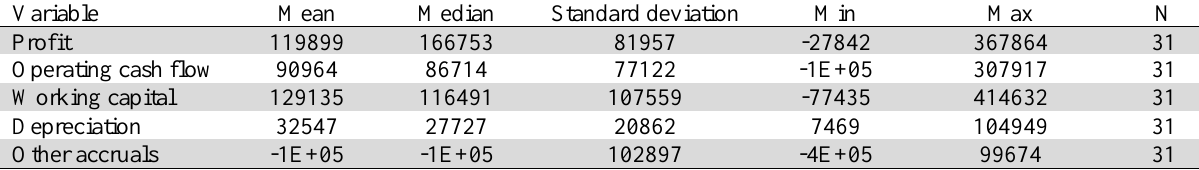
The summary of some basic statistics for the third quartile Variable